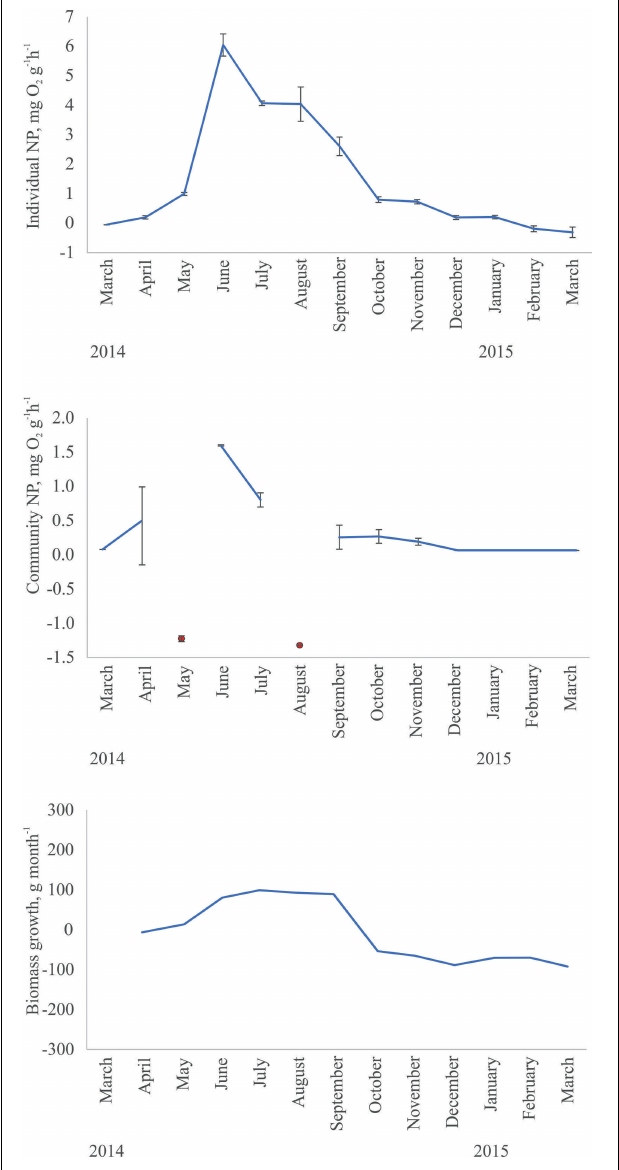
FIGURE 3 | Seasonal dynamics in individual and community net production rates and biomass growth of C. aspera in the study area (means ± Standard Error). Extreme events (negative values) of community net production associated with the presence of high amounts of organic debris on the sediment are shown in red. A moving average smoother was used to visualize the trend in biomass growth.